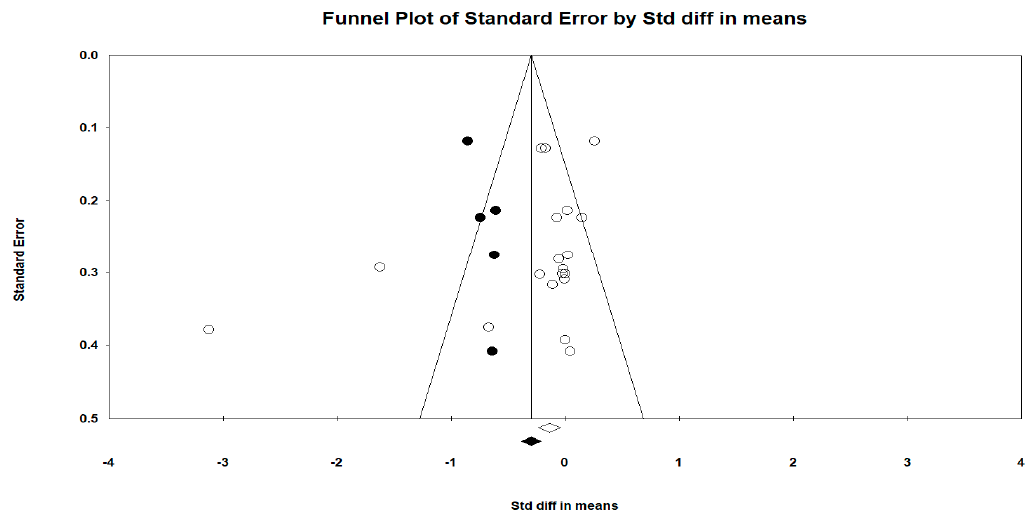
Figure 15. Funnel diagram or “funnel plot” of the standard error (axis of the Y) by the SMD (axis of the X), after incorporating the Duval and Tweedie “trim and fill” procedure. Pre-post intra-group difference in BMI in the group intervened with active video games (all determinations and all follow- ups).